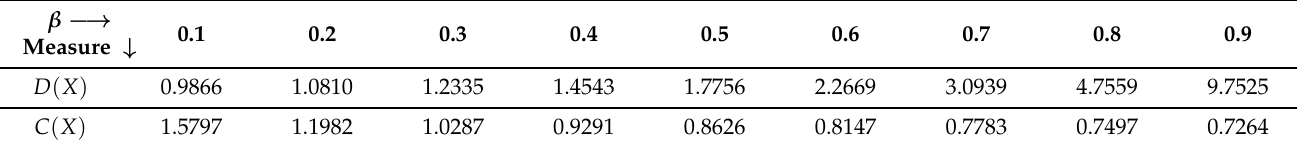
Table 2. The D ( X ) and C ( X ) statistics of the DMEx distribution.